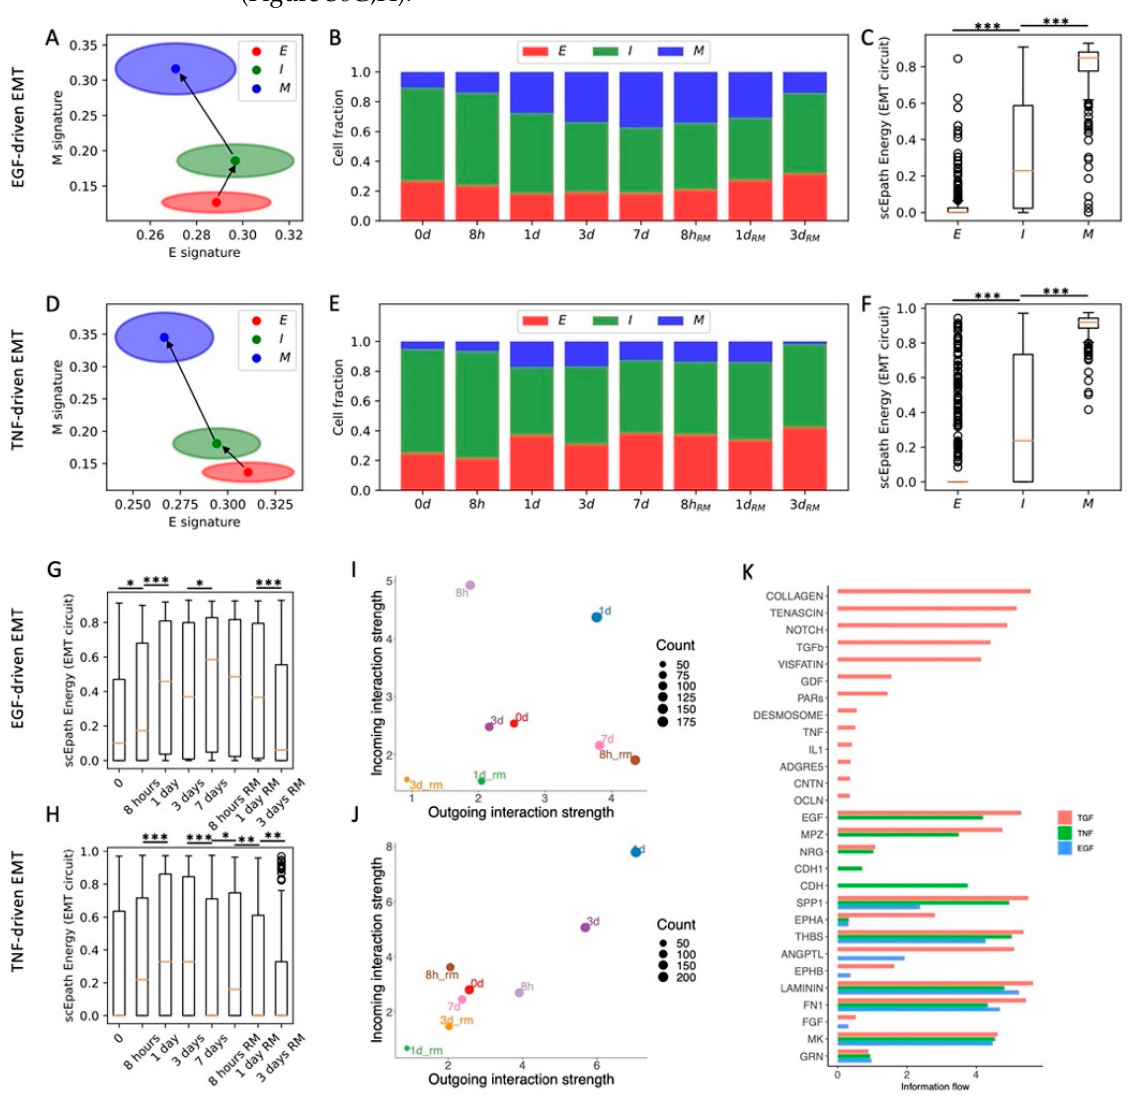
Figure 3. Comparison between TGF-beta-, EGF-, and TNF-driven EMT in OVCA420 cells. ( A ) Projection of clusters of OVCA420 cells under EGF-driven EMT induction in the E-M signature space. Black arrows show the dominant transition trajectory predicted by QuanTC. ( B ) Fraction of E, I, and M cells at different time points during the time course. ( C ) Boxplots depicting EMT circuit energy in the three clusters. ( D – F ) Same as ( A – C ) for OVCA420 cells under TNF-driven EMT. ( G ) Boxplot of EMT circuit energy during the time course of EGF-driven EMT. ( H ) Same as ( G ) for TNF-driven EMT. ( I ) Low-dimensional projection of cell clusters in an incoming/outgoing signaling space for EGF-driven EMT. ( J ) Same as ( I ) for TNF-driven EMT. ( K ) Comparison of signaling pathway information flow between TGF-beta (red), EGF (green), and TNF-driven (blue) EMT. *, **, and *** indicate a p -value < 0.1, 0.01, and 0.001 on a one-tailed t -test, respectively.